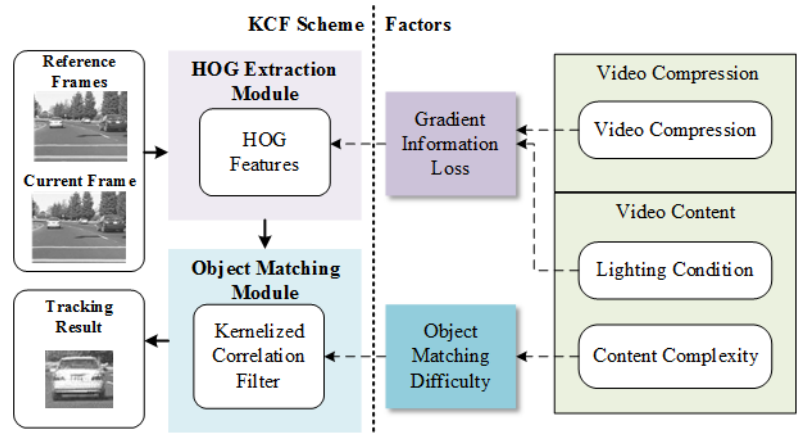
Figure 3. Factors impact on HOG extraction and object matching in KCF scheme.